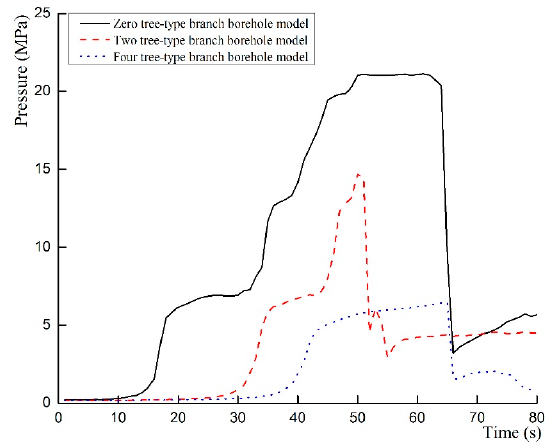
Figure 9. Time–pressure curves of different experimental models, illustrating the decrease in initiation pressure with increasing branches of the tree-type borehole array.